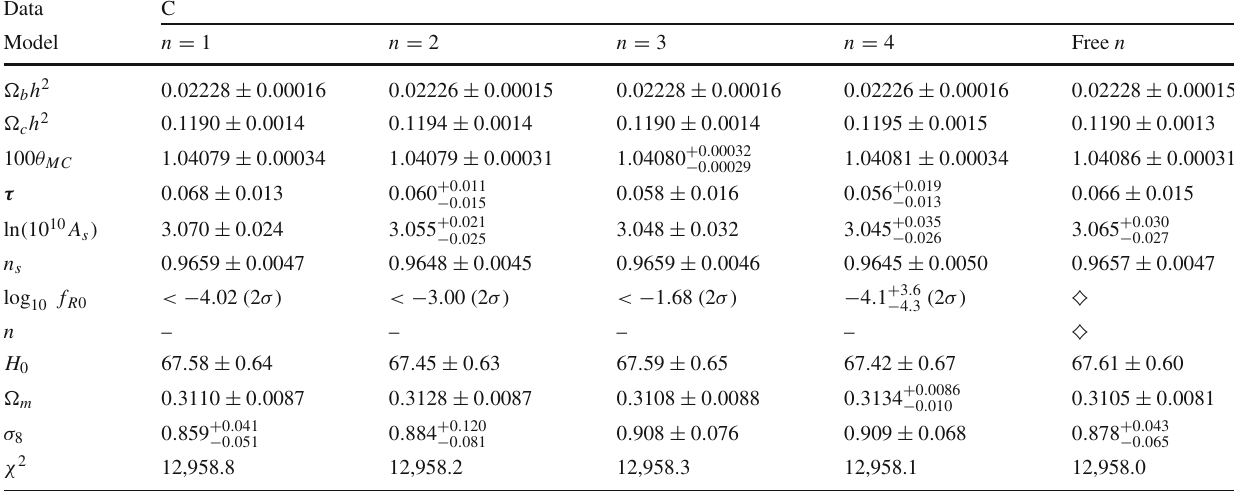
Table 1 The marginalized constraints on the HS f ( R ) models with n = 1, 2, 3, 4 and free n using the “C” dataset are shown, respectively. For the typical parameter log 10 f R 0 , we quote 2 σ ( 95% ) uncertainties